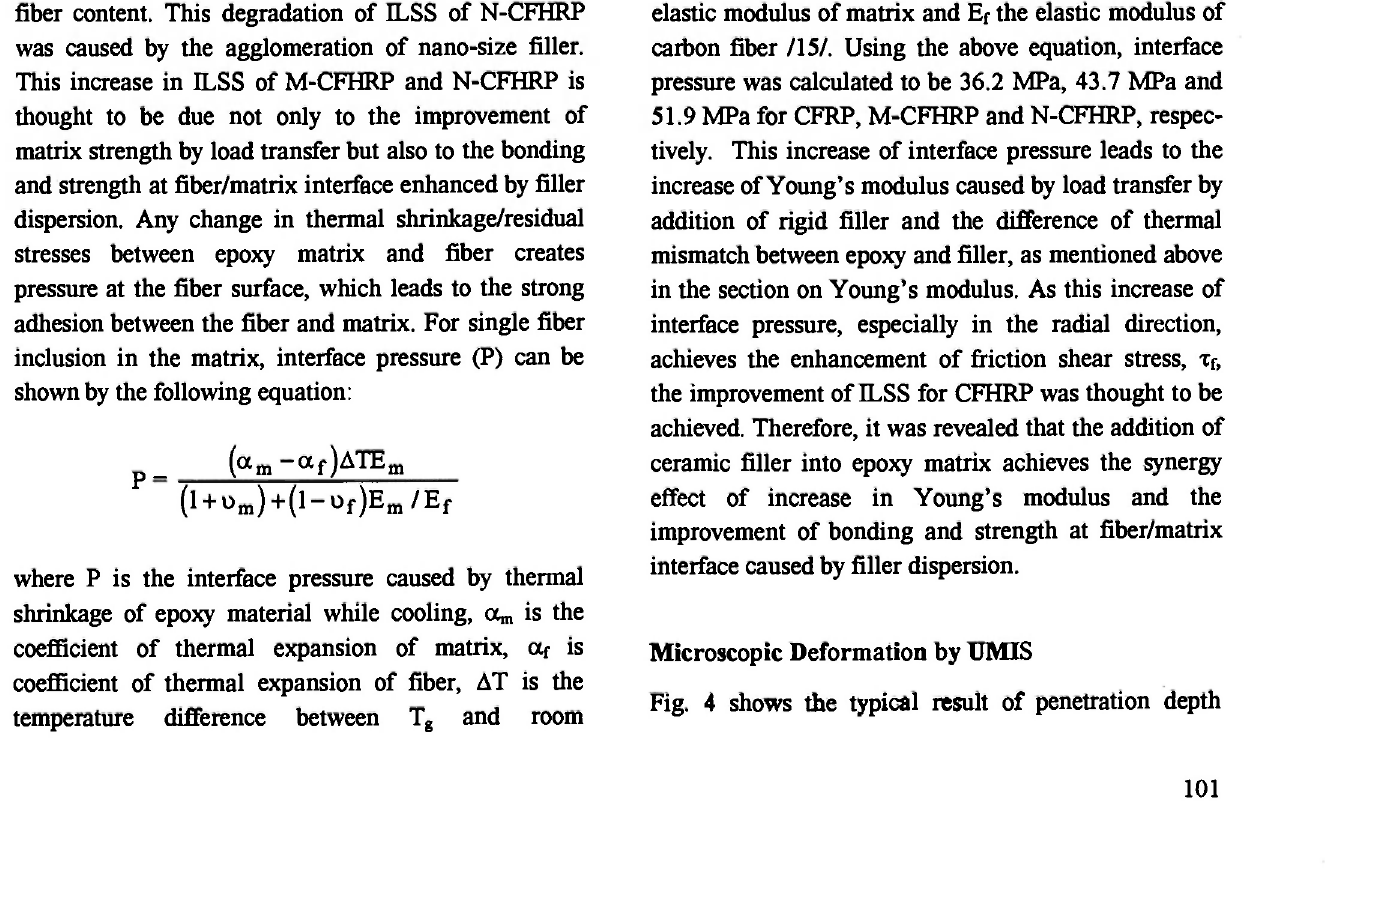
Fig. 3: ILSS as a function of fiber content for CFRP, M-CFHRP and